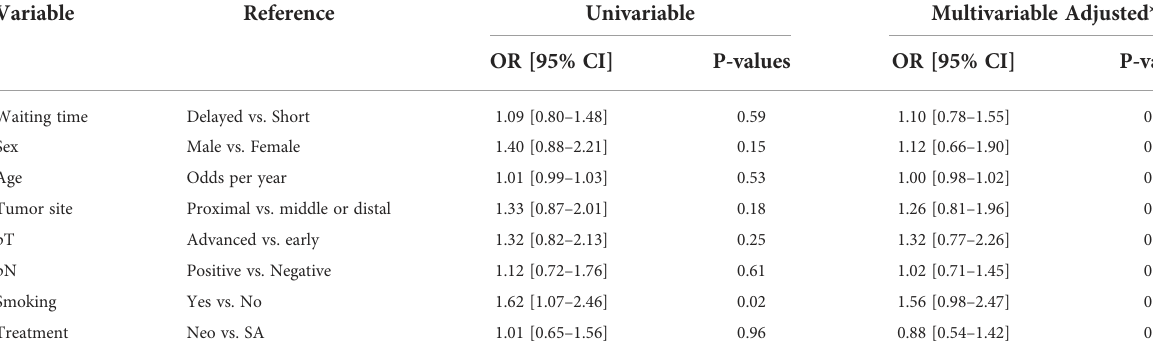
TABLE 6 Univariable and multivariable logistic regression models of the risk factors for prolonged postoperative stay.